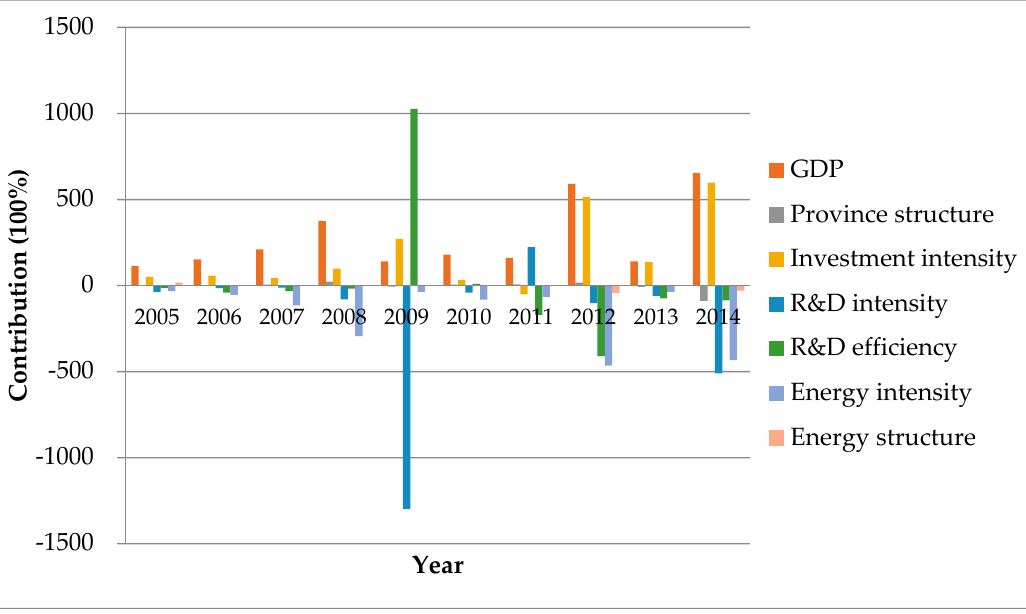
Figure 6 . The year-by-year contributions of different factors of carbon emissions from energy consumption of China in 2005–2014.